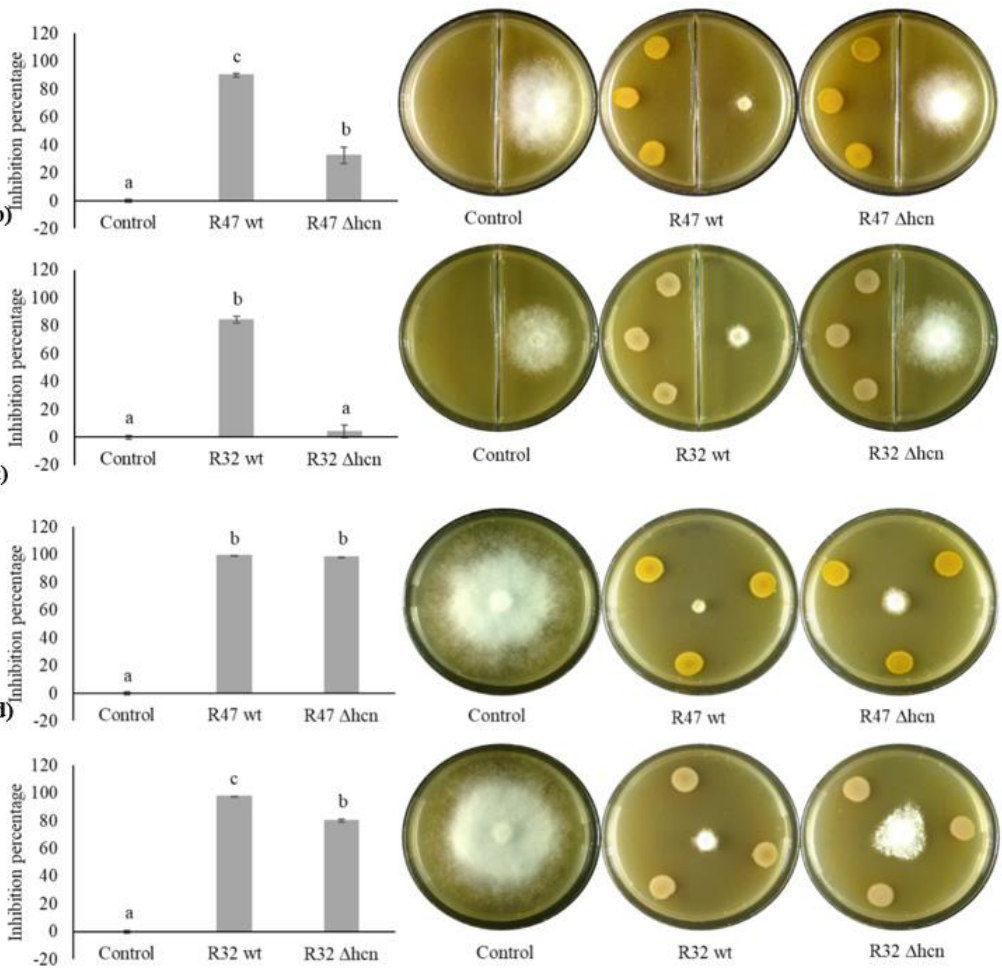
Figure 1. Effect of R47 (wt and ∆hcn) and R32 (wt and ∆hcn) strains on Phytophthora infestans mycelium growth. ( a,b ) Volatile compound-mediated dual assay; ( c,d ) diffusible compound-mediated dual assay. Left panels: quantification of mycelium growth of P. infestans represented as inhibition percentages. The bars show averages ( n = 3 independent assays with 3 – 4 technical replicates) with error bars indicating standard error of the mean. Letters indicate significant differences between treatments as per ANOVA followed by Tukey’s honestly significant difference (HSD) (threshold p < 0.05); Right panels: representative images of dual assays corresponding to the graphs on the left.